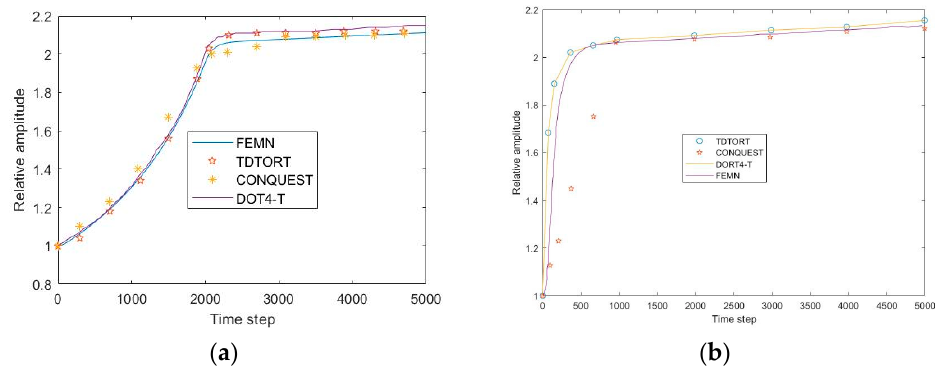
Figure 5. Neutronics calculation results of benchmark TWIGL (( a ) linear perturbation and ( b ) step perturbation).